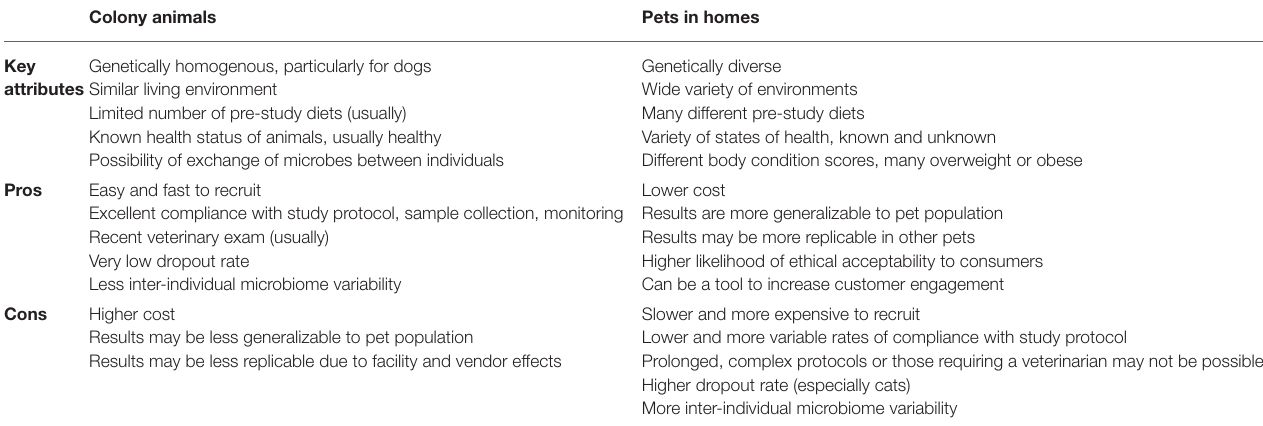
TABLE 1 | Comparison of using colony animals or household pets in an intervention study. Colony animals Pets in